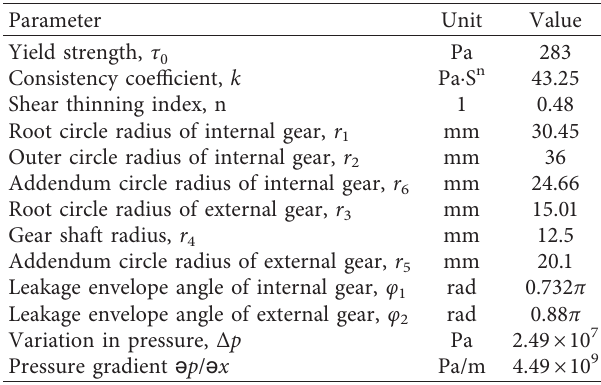
Table 4: Calculation parameters of power loss of end